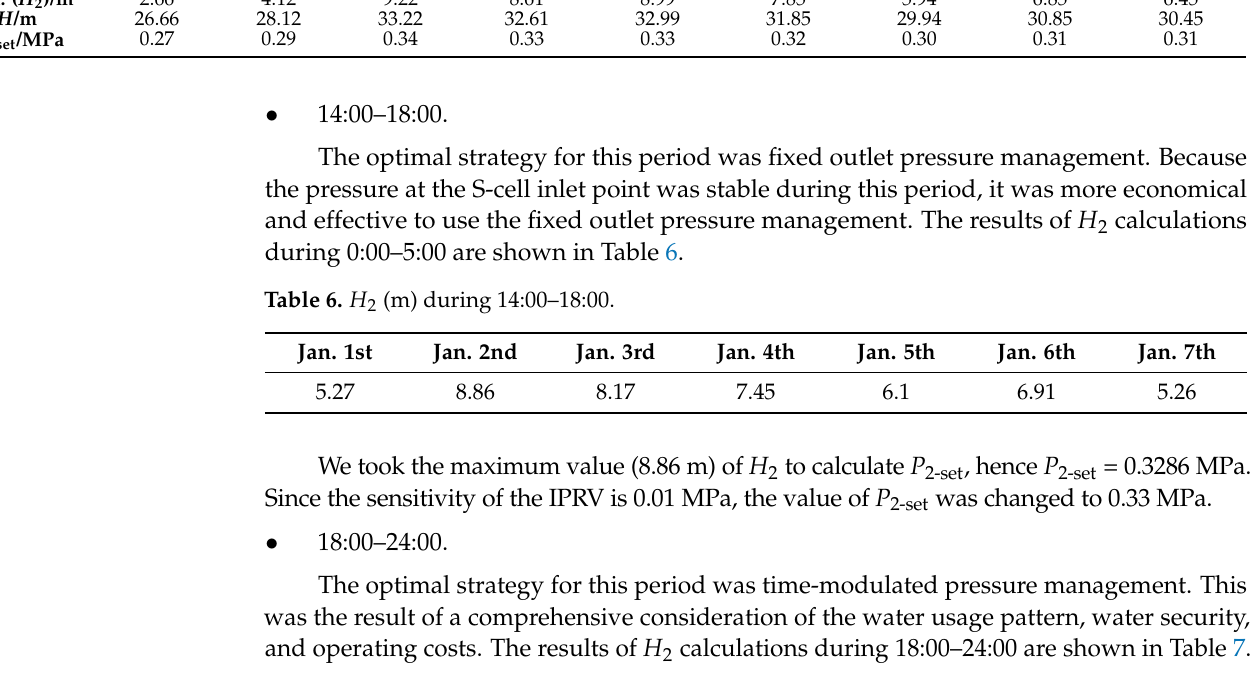
Table 7. H 2 (m) during